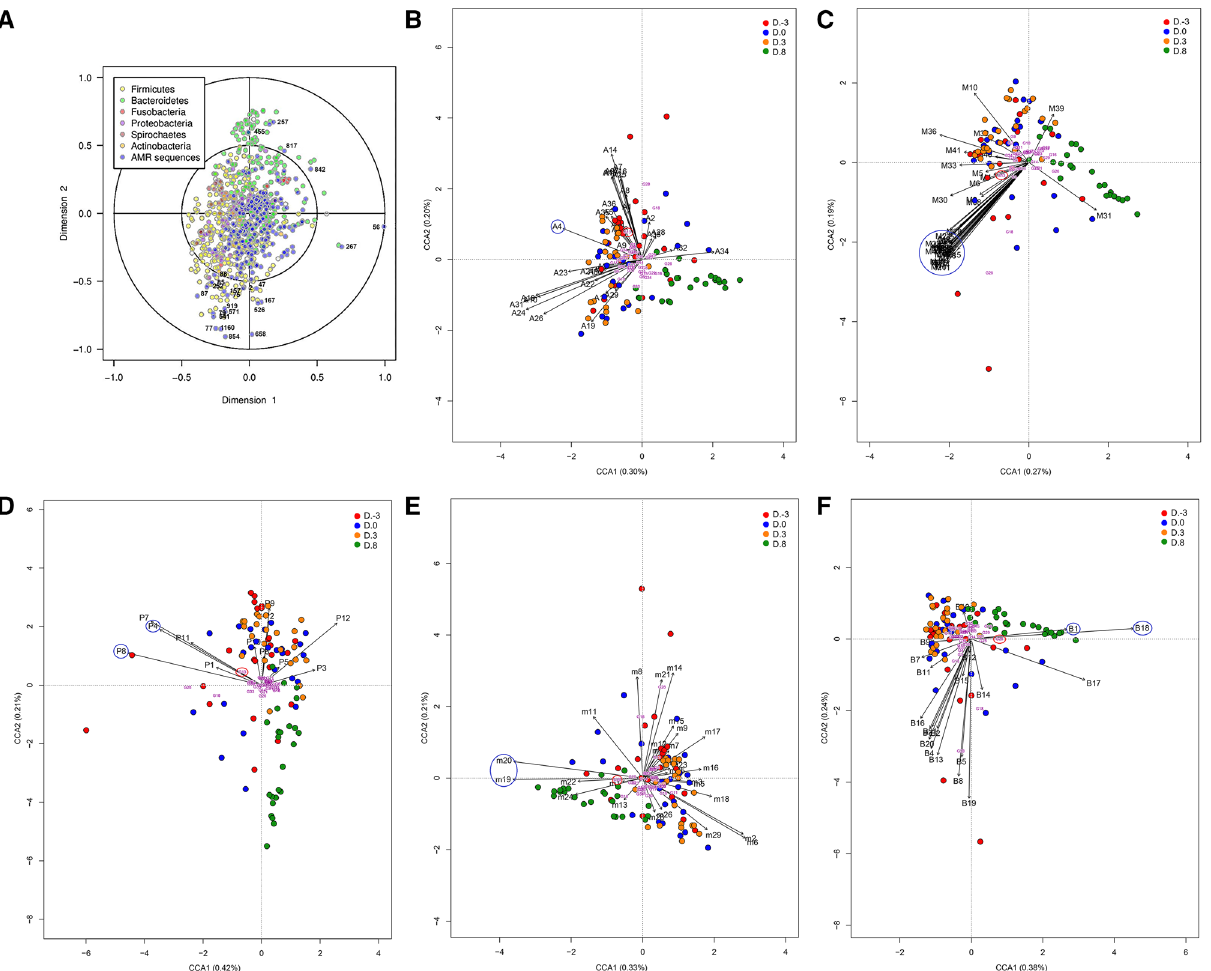
Figure 3. Canonical correlation analysis (CCA) plot showing the distribution of piglets at day 3 pre-weaning (D. − 3), weaning day (D.0), days 3 (D.3) and 8 post-weaning (D.8). Microbiome genera and antimicrobial resistance (AMR) genes according to corresponding antimicrobial drug resistance patterns. CCA plot showing inter-relationships between taxon abundance profiles and AMR sequences over all 96 samples ( A ). CCA plot of AMR genes corresponding to aminoglycoside drug resistance pattern ( B ). CCA plot of AMR genes corresponding to multidrug resistance pattern ( C ). CCA plot of AMR genes corresponding to phenicol drug resistance patterns ( D ). CCA plot of AMR genes corresponding to macrolide, lincosamide and streptogramin resistance (MLS) patterns ( E ). CCA plot of AMR genes corresponding to β-lactam resistance patterns ( F ). Blue circles indicate high abundant genes correlated with Escherichia or Prevotella . Red circles indicate Escherichia (G13) and Prevotella (G26). AMR genes ( A ) rpo B2 (2), par